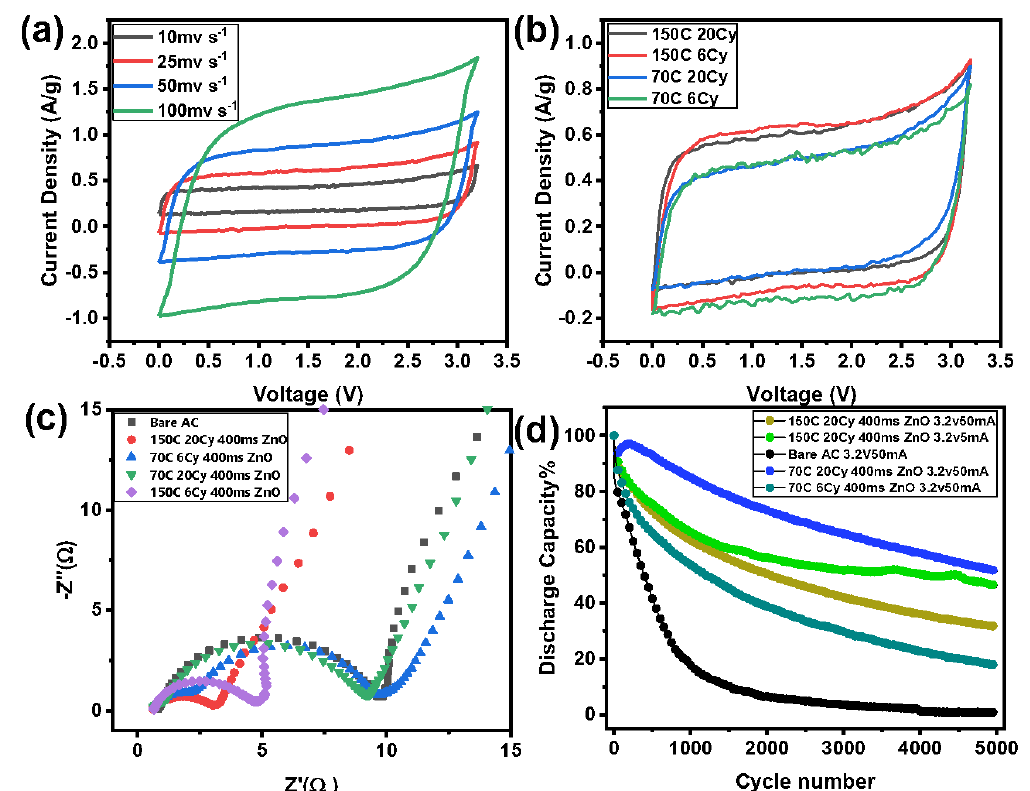
Figure 9. Comparison between bare AC and ZnO-coated AC samples using 400 ms pulse time: ( a ) C-V of 20-cycle ZnO- coated at 150 ◦ C; ( b ) C-V of ZnO-coated sample at 70 ◦ C and 150 ◦ C; ( c ) Electrochemical impedance spectrum of bare AC and coated AC at various conditions; ( d ) Cyclic stability at 3.2 V and /50 mA for 5000 cycles of various samples.